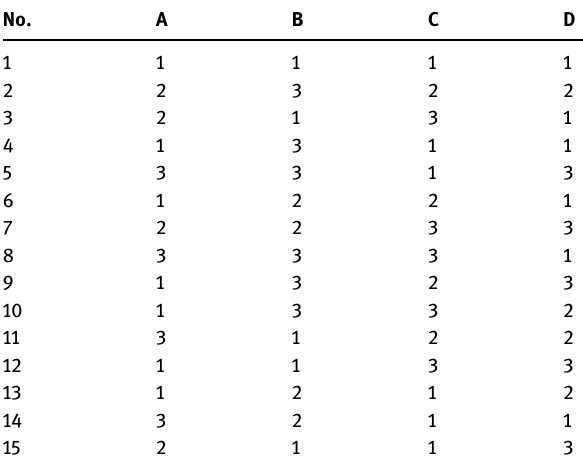
Table 2: Orthogonal array for the experiment